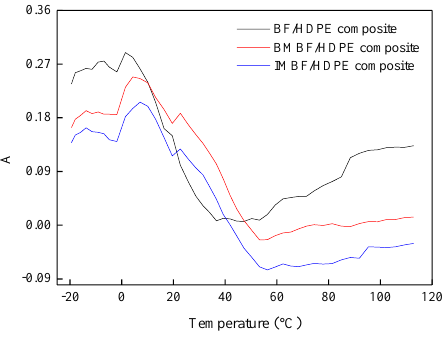
Figure 6. A values of composites.